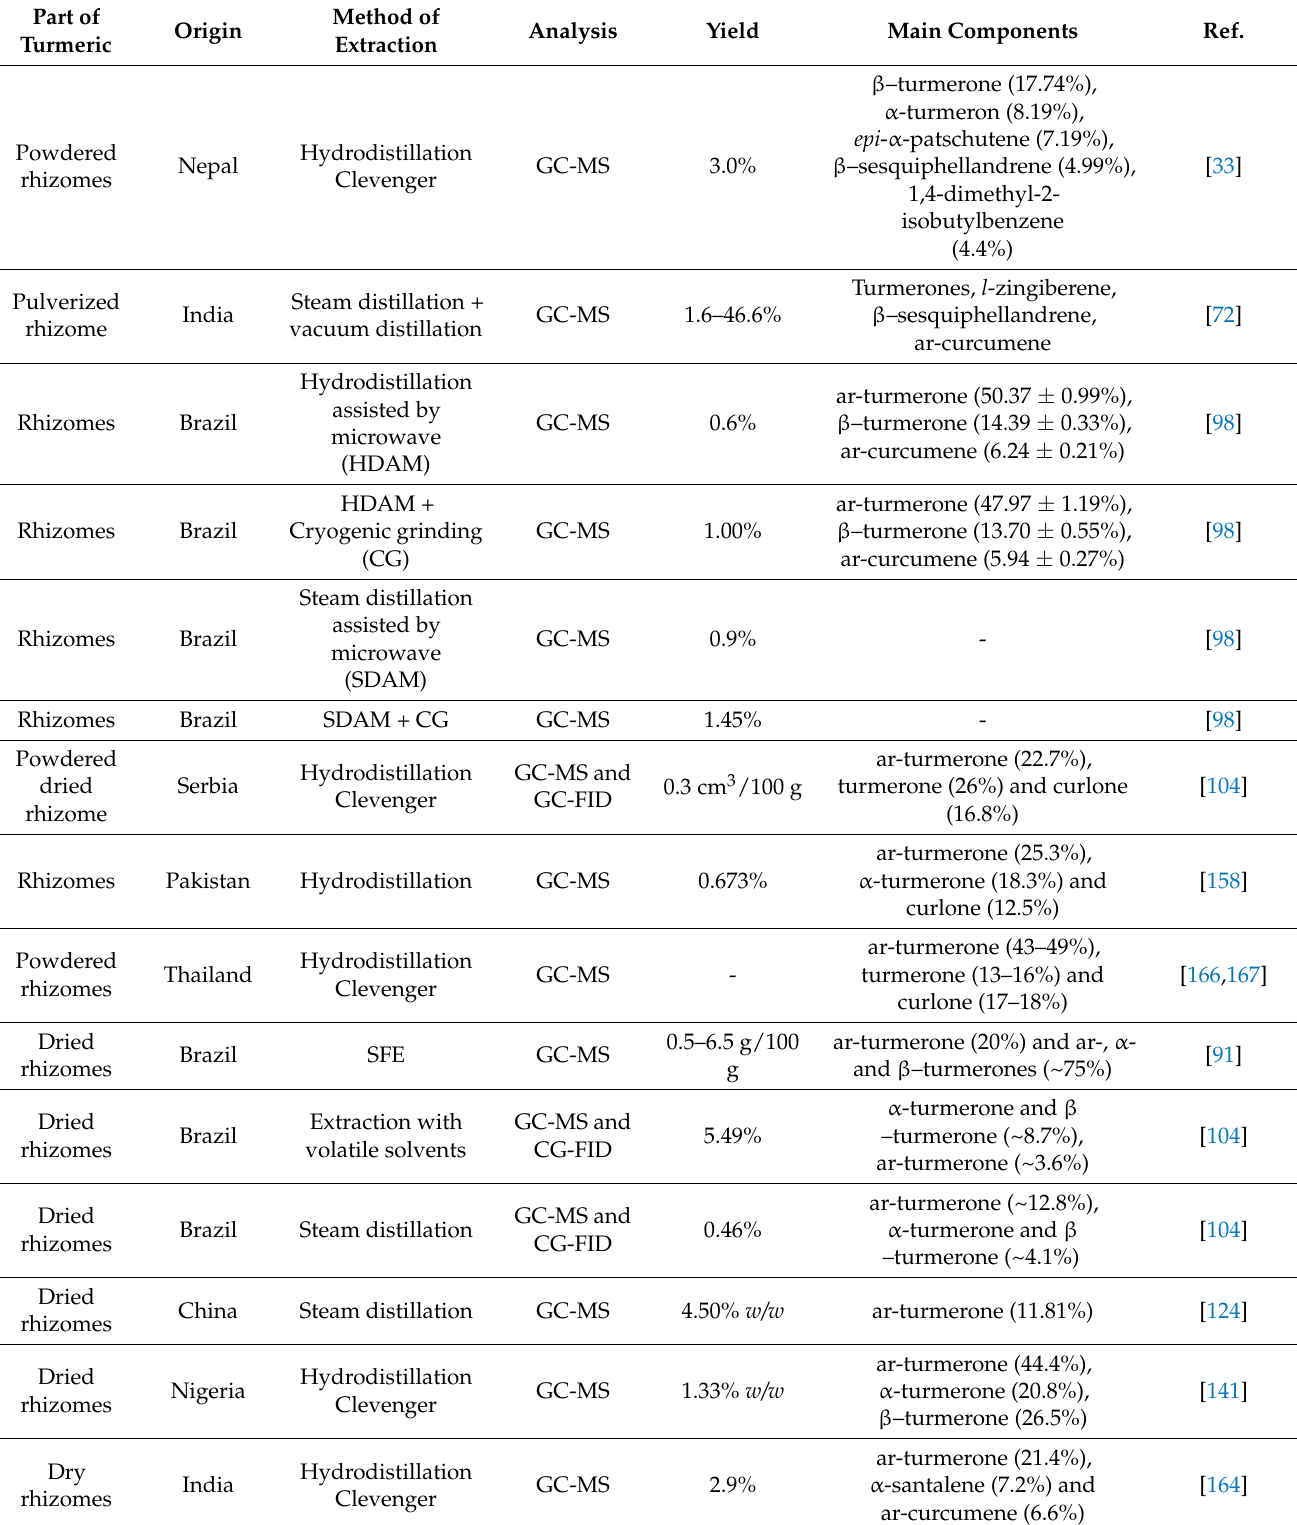
Table 2. Main components of C. longa essential oil according to the part of the plant used, origin, method of extraction and analysis.